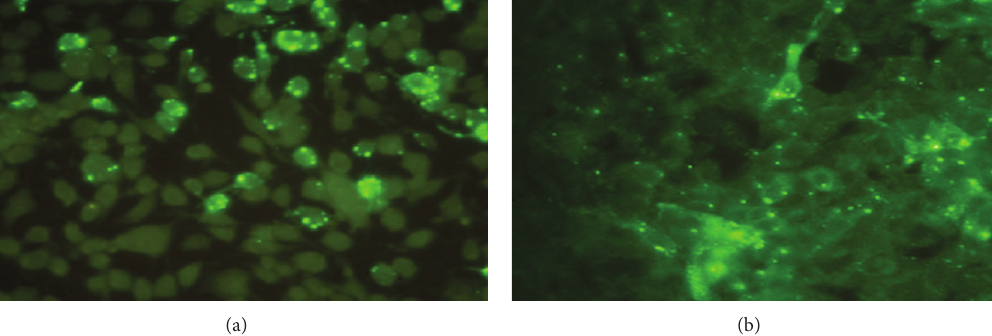
Figure 3: Virus isolation in cell culture: street virus infected Neuro-2a (a) and HEK 293 (b) stained with fluorescent antibody technique